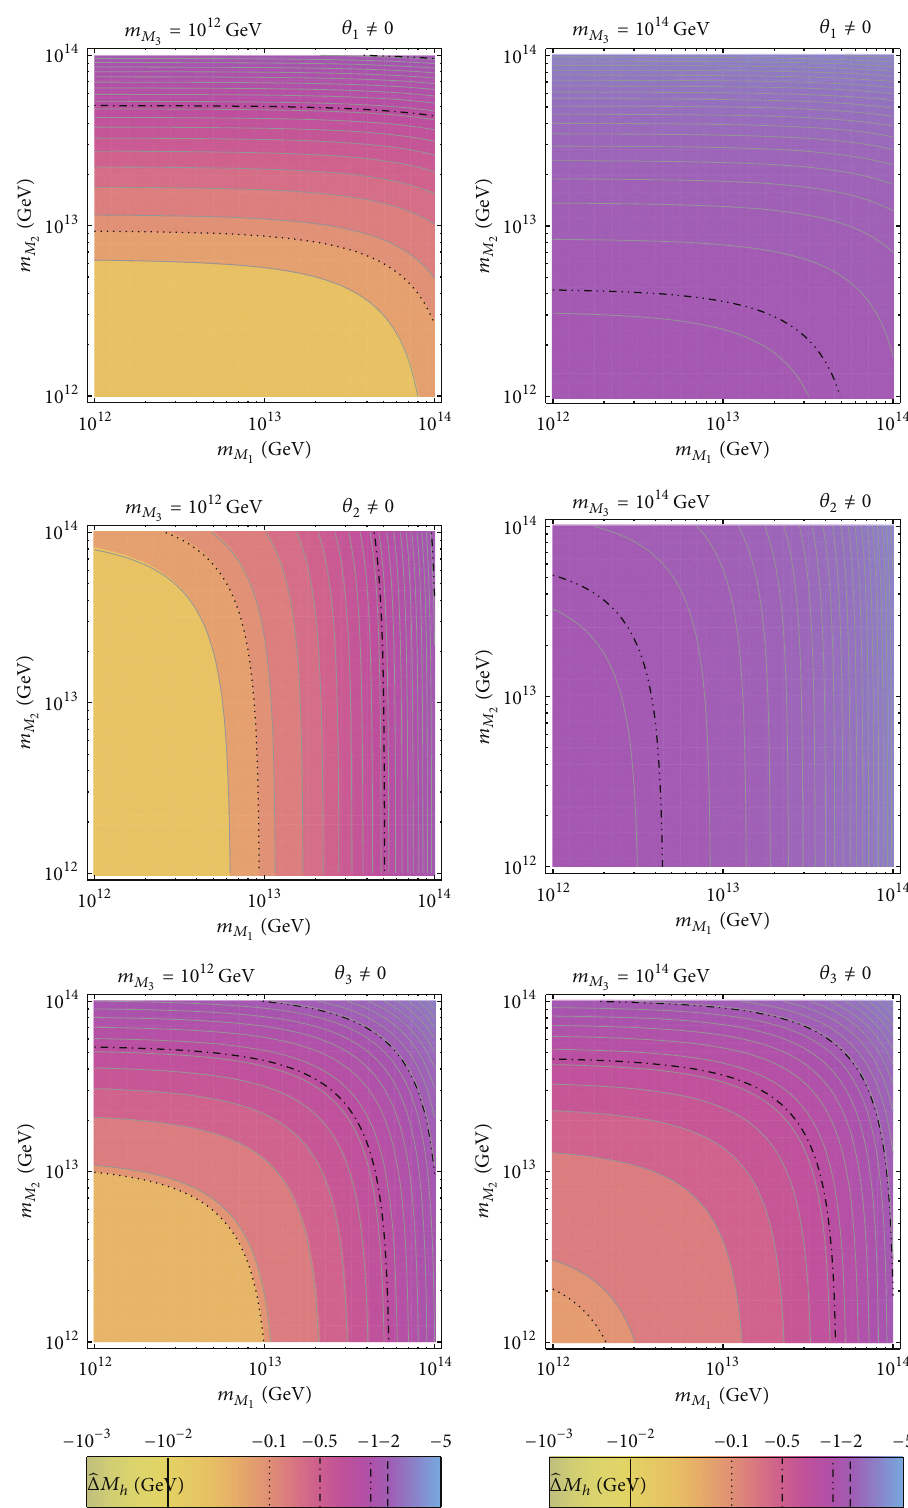
̂Δ𝑀 Figure 10: ℎ contour lines in the ( = 10 12 GeV. Right panels: with 𝑚 with 𝑚 𝑀 3 = 3 𝜋/ 4 𝑒 𝑖𝜋/ 4 , 𝜃 Bottom panels: 𝜃 3